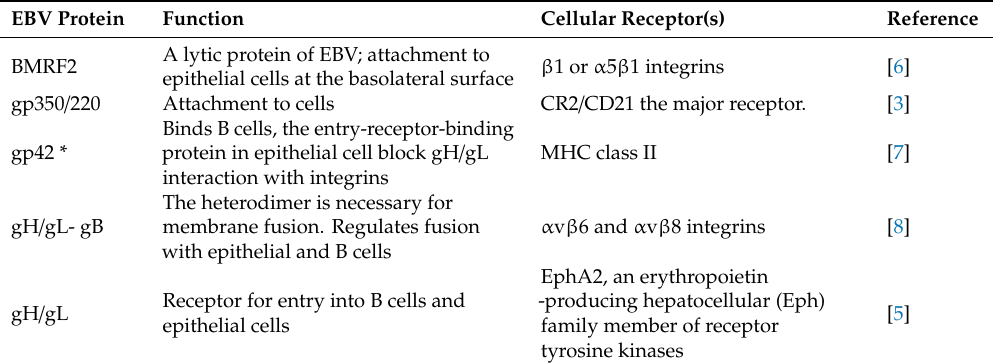
Table 1 summarizes the data of receptors and co-receptors used by EBV to gain entry into cells. Table 1. Epstein–Barr virus (EBV) protein and receptor